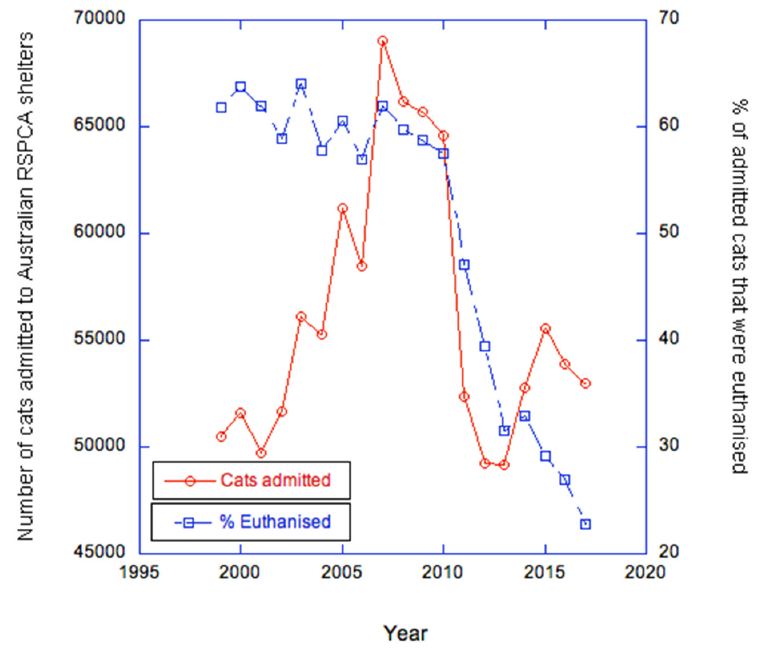
Figure 1. Cats admitted to Australian RSPCA shelters and % of those cats euthanised between 1999/2000 and 2017/2018. Source: RSPCA Australia (2019).